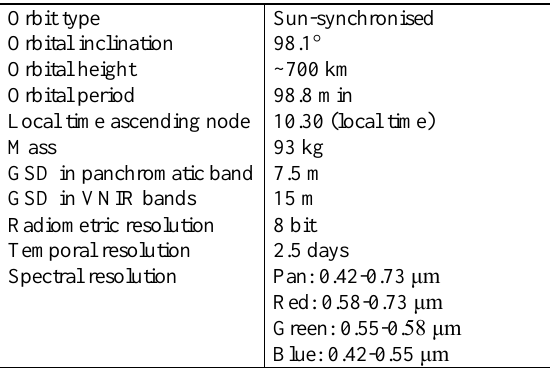
Table 1. Specifications of